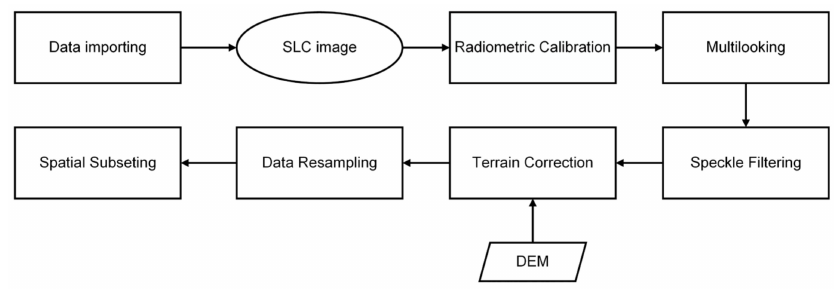
Figure 2. The preprocessing flowchart of the PALSAR-2